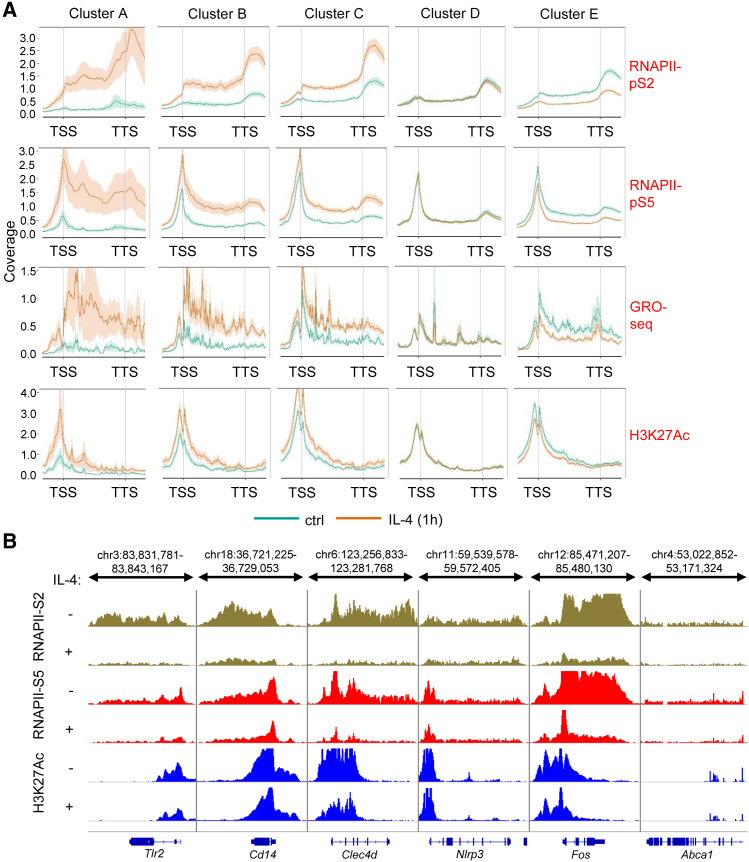
Changes in RNAPII and H3K27Ac Enrichments as well as Nascent RNA Transcription Are Immediate Early Markers of IL-4-STAT6-Regulated Transcription(A) Metagene plot of RNAPII-pS5-, RNAPII-pS2-, and H3K27Ac-specific ChIP-seq enrichments and GRO-seq signals on the gene bodies of regulated gene clusters (Figure 1A) in the presence of IL-4 in WT BMDMs (TSS, transcription start site; TTS, transcription termination site). Coverage is defined as read count per million mapped reads. Data (H3K27Ac, RNAPII-pS2, and RNAPII-pS5) are combined from two independent biological replicates.(B) H3K27Ac, RNAPII-pS5, and RNAPII-pS2 ChIP-seq signals at the selected IL-4-repressed gene bodies. ChIP-seq signals are visualized by the Integrative Genomics Viewer. Data are representative of two independent biological replicates.BMDMs were treated with IL-4 for 1 hr.